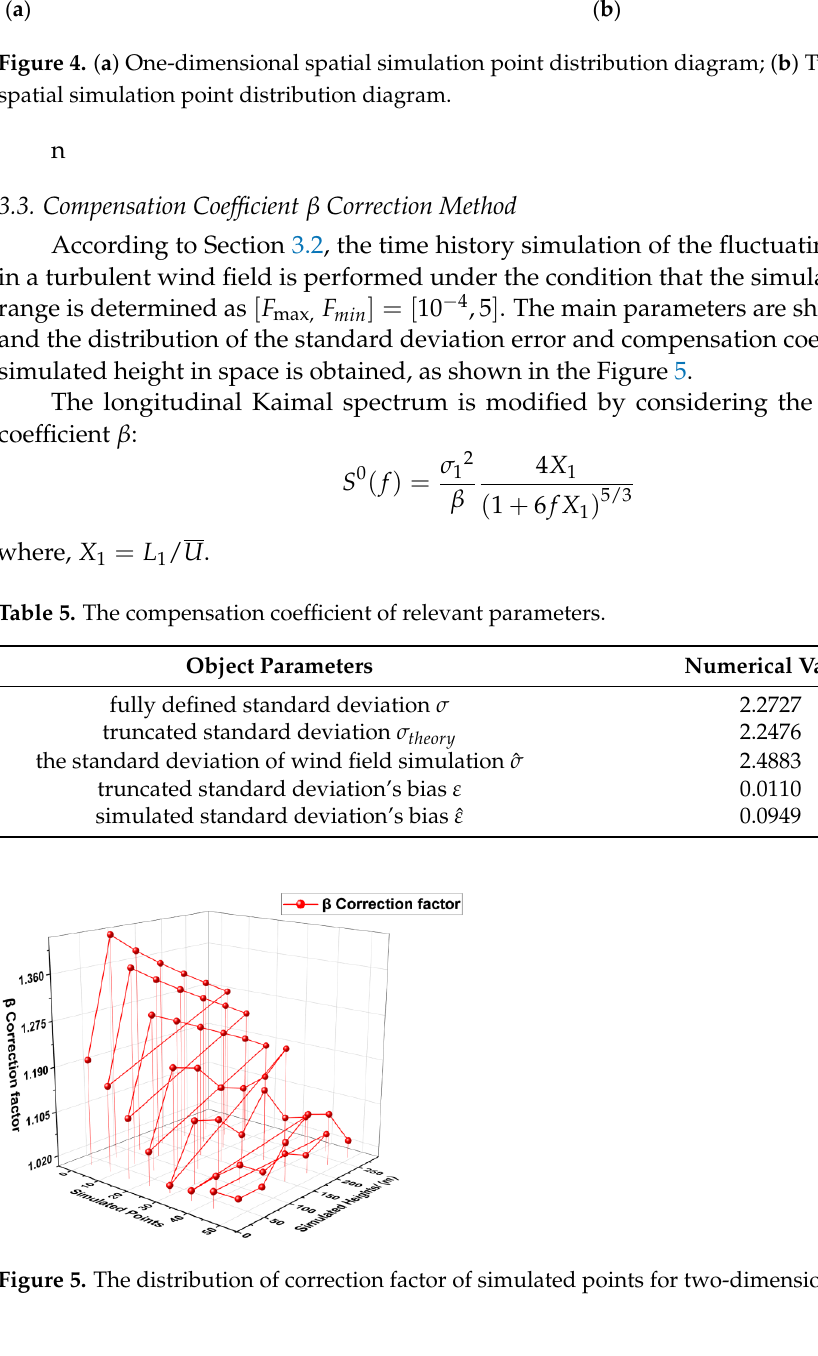
Figure 4. ( a ) One-dimensional spatial simulation point distribution diagram; ( b ) Two-dimensional spatial simulation point distribution diagram.